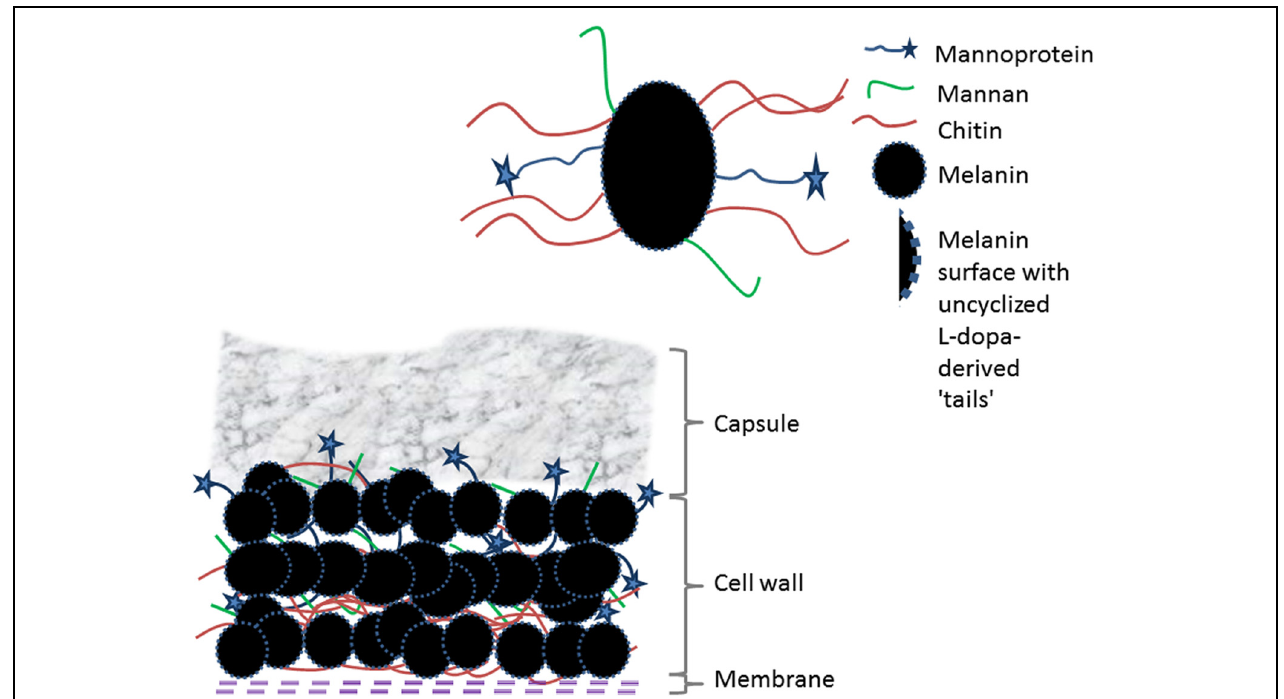
FIGURE 1 | A conceptualization of melanin organization and identified interactions with macromolecular structures in the cell wall of Cryptococcus neoformans